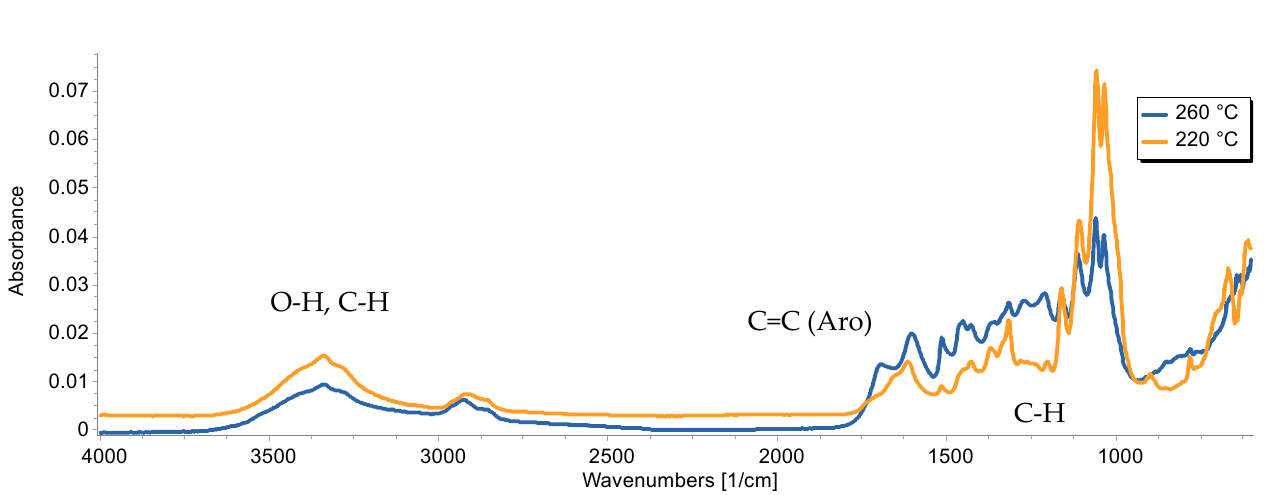
Figure 4. FTIR spectrograph of hydrochar produced at 260 °C and 220 °C.